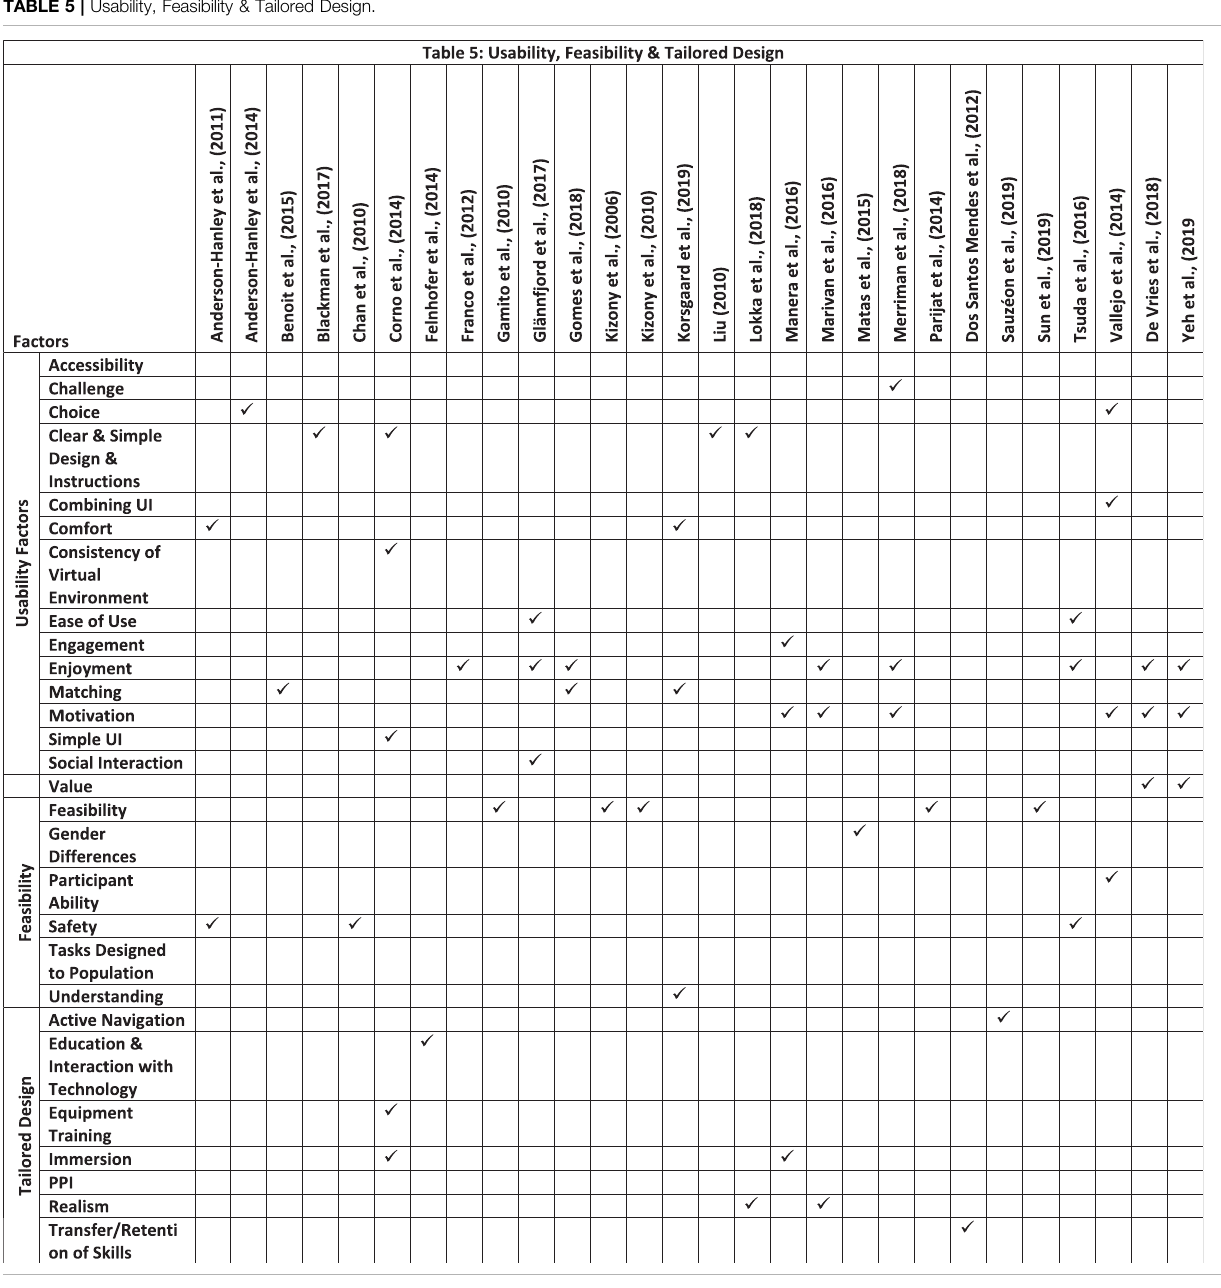
TABLE 5 | Usability, Feasibility & Tailored